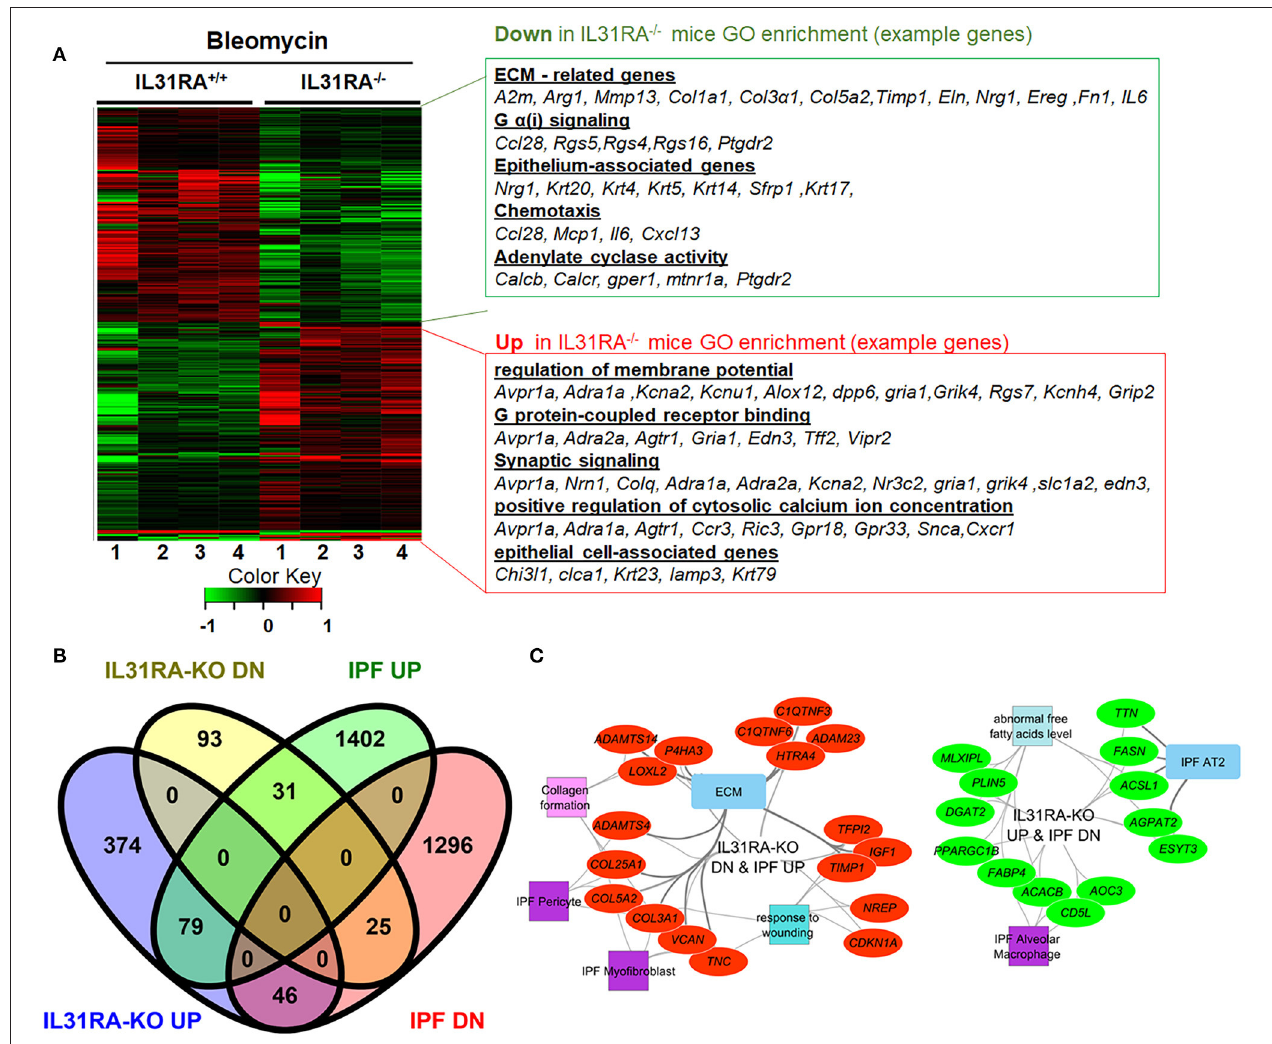
FIGURE 2 | The IL-31-IL-31RA axis regulated gene networks during bleomycin-induced pulmonary fibrosis and IPF. Total lung RNA was isolated from bleomycin or saline-treated mice and performed RNA-seq analysis. (A) The heat map shows two clusters of differentially expressed genes that were up-or down-regulated by at least 1.5-fold upon bleomycin treatment of genetic knockdown of IL-31RA compared to wildtype mice. Gene Ontology Enrichment analysis for IL-31RA-dependent gene transcripts was performed using ToppFun. (B) Venn diagram of IL31RA-regulated genes compared with differentially expressed lung transcripts of IPF patients. (C) IL-31RA-driven gene networks that are activated in IPF were analyzed using ToppFun and visualized using Cytoscape. Red- and green-colored oval shapes represent genes that are IL31RA-regulated and up-or down-regulated, respectively in IPF lungs. Both square and rectangle shapes represent different enriched biological processes and cell types for the inversely correlated genes between the IL-31-IL-31RA axis and